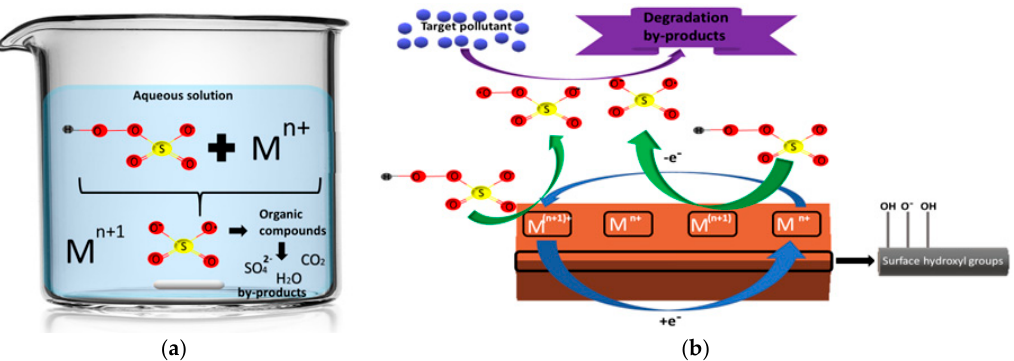
Figure 2. Schematic representation of PMS activation in ( a ) homogeneous and ( b ) heterogeneous system.